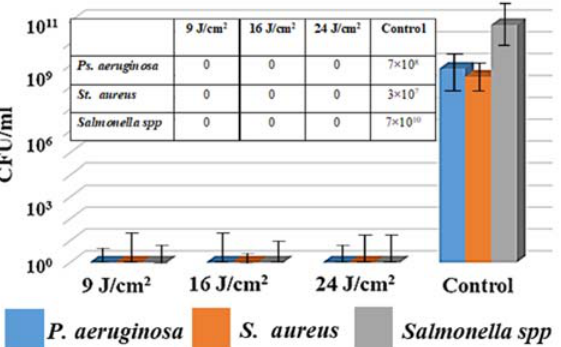
Figure 7. Antibacterial effect (in CFU/mL) of Ag NPs transferred at various laser fluences from silver metal films on biofilms of clinical isolates; inserts: tabular data.